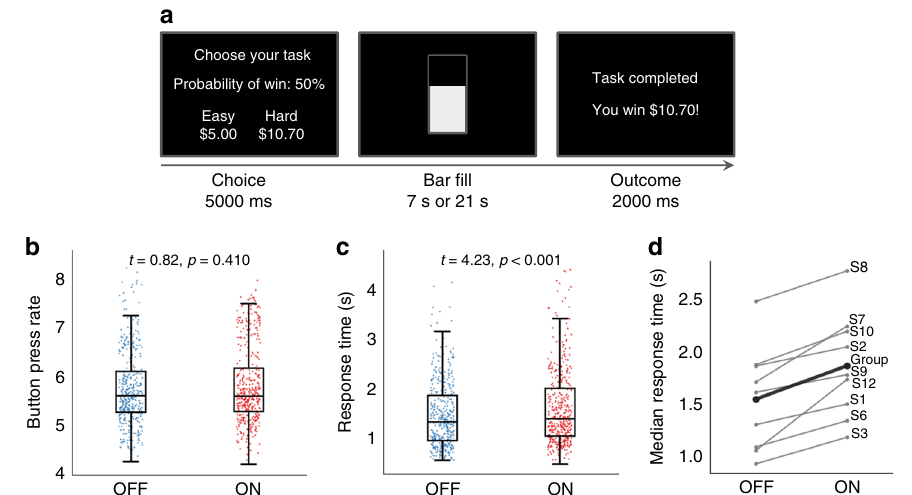
Fig. 2 Deep brain stimulation (DBS ’ ) bene fi cial effects are speci fi c to con fl ict decision-making. a Effort expenditure for rewards task (EEfRT) 27 . Subjects are presented with a choice of an “ easy ” or “ hard ” trial. In either, they must press a key quickly many times to fi ll up a bar, but “ hard ” trials require more presses and use the non-dominant hand. “ Hard ” trials offer a larger but uncertain reward, forcing subjects to quickly make a choice between gains. Choices are presented with time pressure that prevents formal expected value calculations. The subject then performs their chosen key-pressing within a set interval (7 s for easy, 21 s for hard), with a chance of reward (right panel). Failure to perform suf fi cient key presses in time yields no reward. b DBS ON/OFF difference in button pressing rates during EEfRT. Press rates under the two conditions were not signi fi cantly different (mixed effects Gamma regression with nine participants and 794 observations; t = 0.824, p = 0.410), suggesting that ventral internal capsule/ventral striatum (VCVS) DBS has no effect